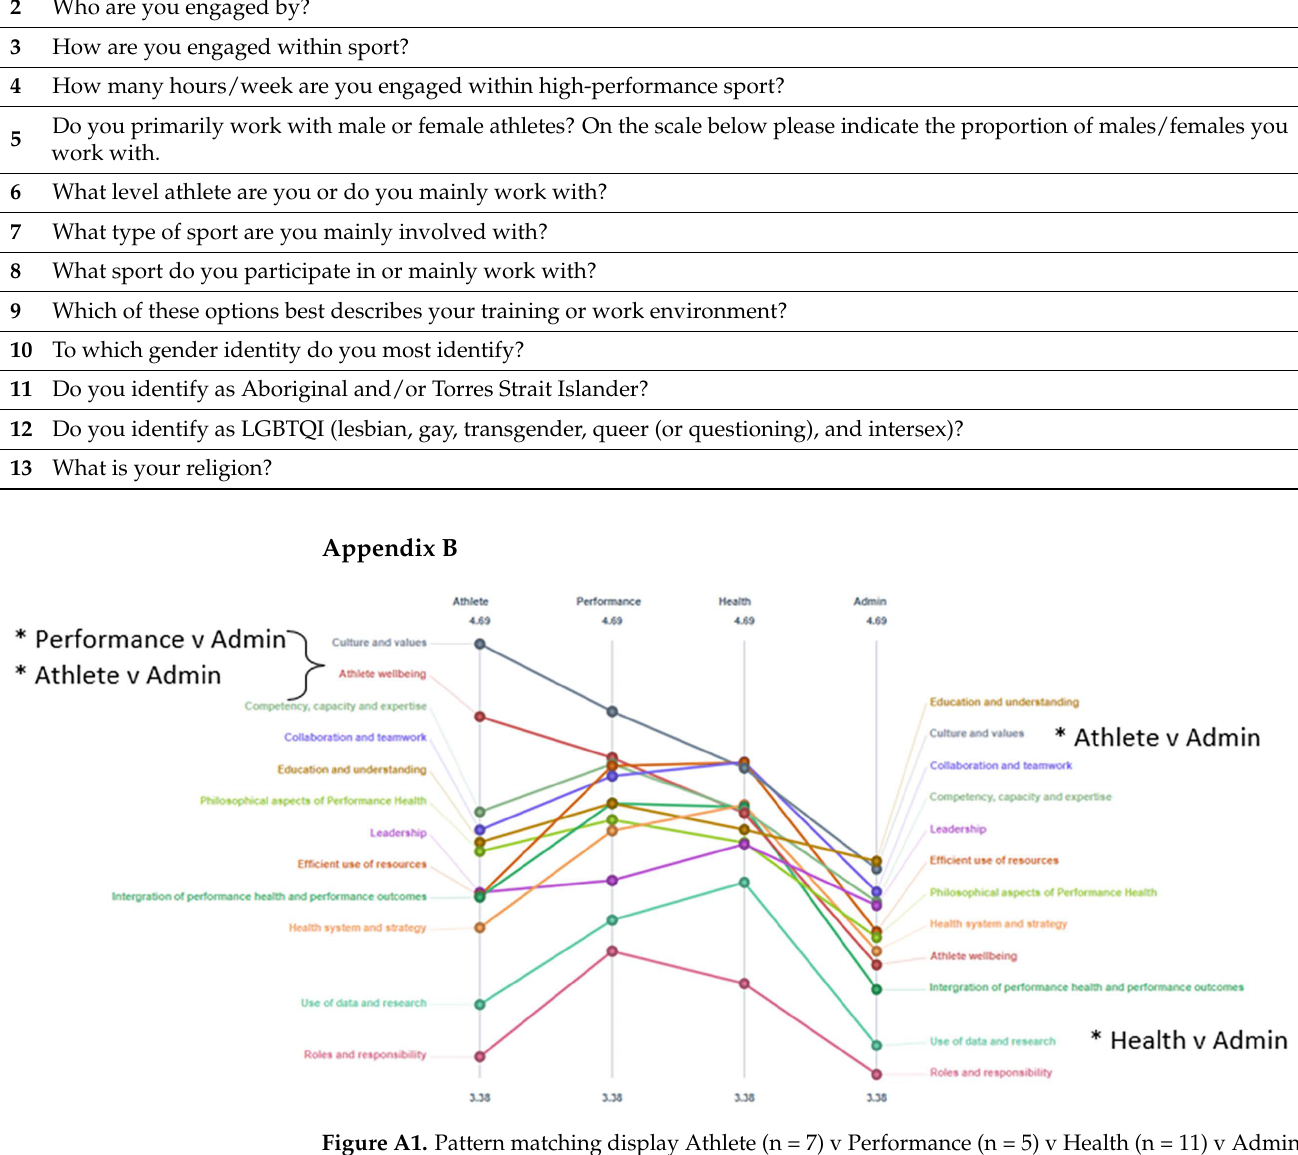
Figure A1. Pattern matching display Athlete (n = 7) v Performance (n = 5) v Health (n = 11) v Admin- istration (n = 6). Performance = Coaches, Strength and Conditioning Coaches, Performance Pathways, Sports Engineers Health = Physiotherapists, Psychologists, Epidemiologists, Clinical Research, Health Communication, Administration = Directors, High Performance Managers, Performance Health Managers, AIS Management, * p ≤ 0.05, significant difference between stakeholders for cluster mean importance